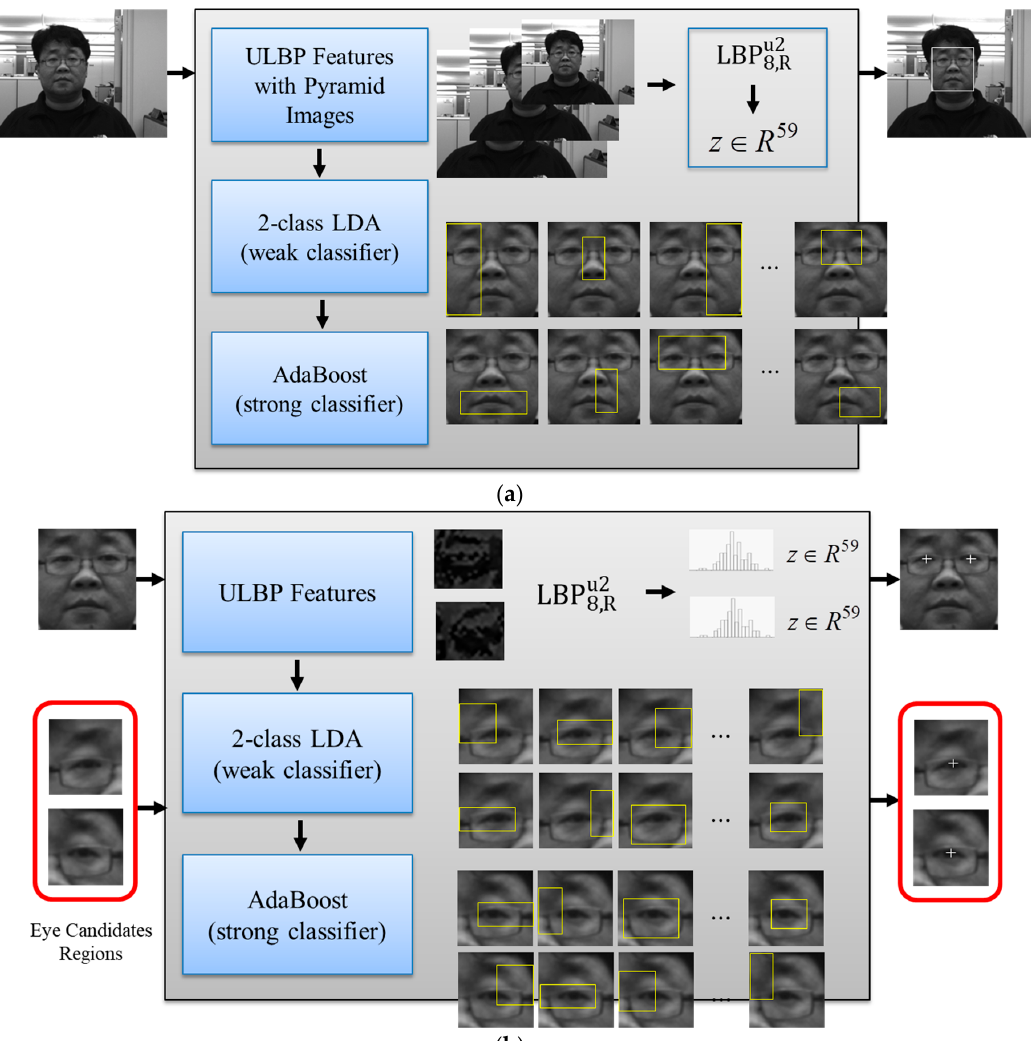
Figure 2. The local binary pattern (LBP)-AdaBoost approaches to face detection ( a ) and eye detection ( b ) for facial image alignment. LDA: linear discriminant analysis.